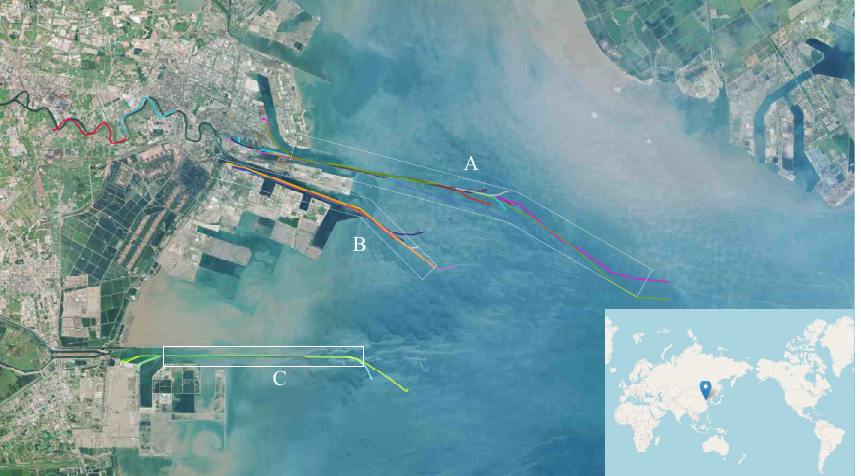
Figure 1. Research port area and the trajectory of in-wharf vessels and out-wharf vessels.